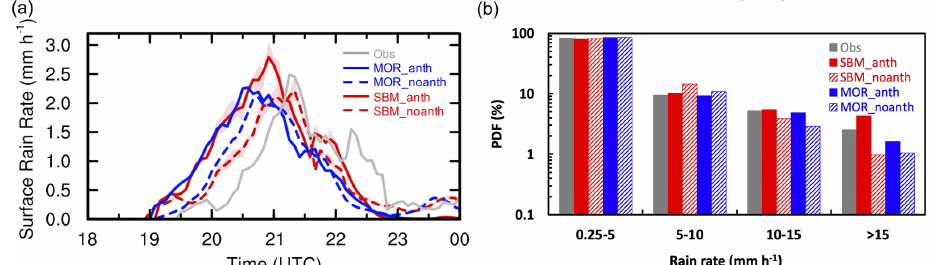
Figure 9. (a) Time series of the averaged surface rain rate (unit: mmh − 1 ) and (b) probability density functions (PDFs) of the rain rate for values larger than 0.25mmh − 1 over the study area (red box in Fig. 7) from observations (gray), from SBM_anth and SBM_noanth (red), and from MOR_anth and MOR_noanth (blue) from 18:00UTC on 19 June 2013 to 00:00UTC on 20 June 2013. The observed precipitation rate is obtained by the NEXRAD-retrieved rain rate. Both observational and model data are at a frequency of every 5min. The results are the three ensemble means. The shaded areas mark the spread of the ensemble